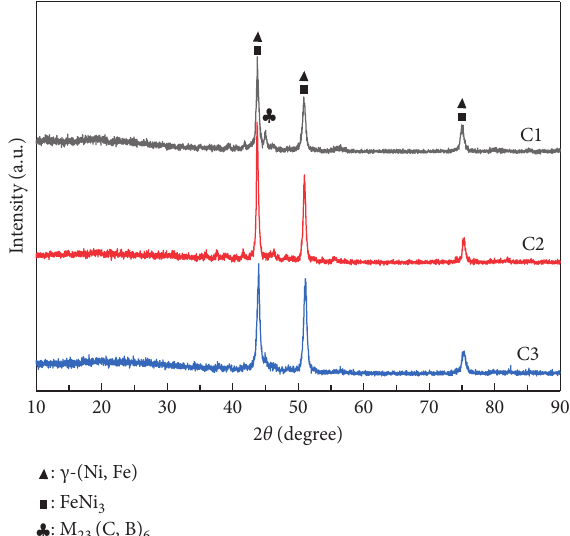
Figure 6: XRD patterns of as-prepared Ni45 coatings.